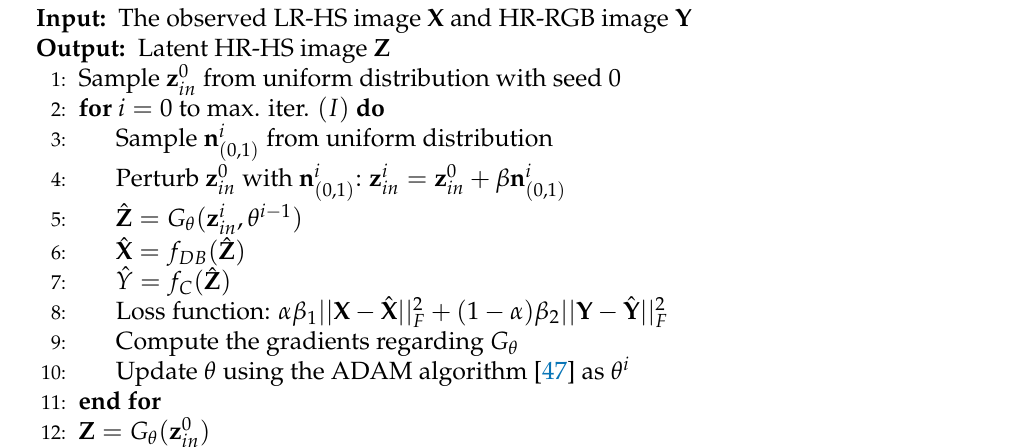
Algorithm 1 Algorithm of the proposed deep unsupervised fusion learning